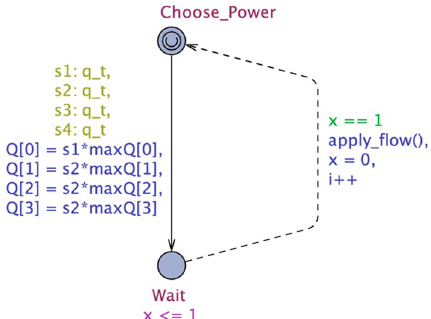
Fig. 7 UPPAAL-STRATEGO network of timed automata representing the understudy building model